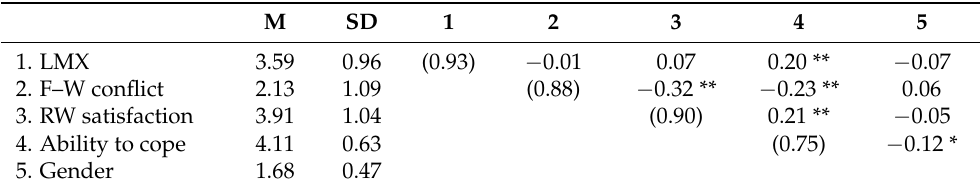
Table 1. Descriptive statistics, Cronbach’s alphas (between brackets), and Pearson’s correlations between continuous/dichotomous (gender) variables.